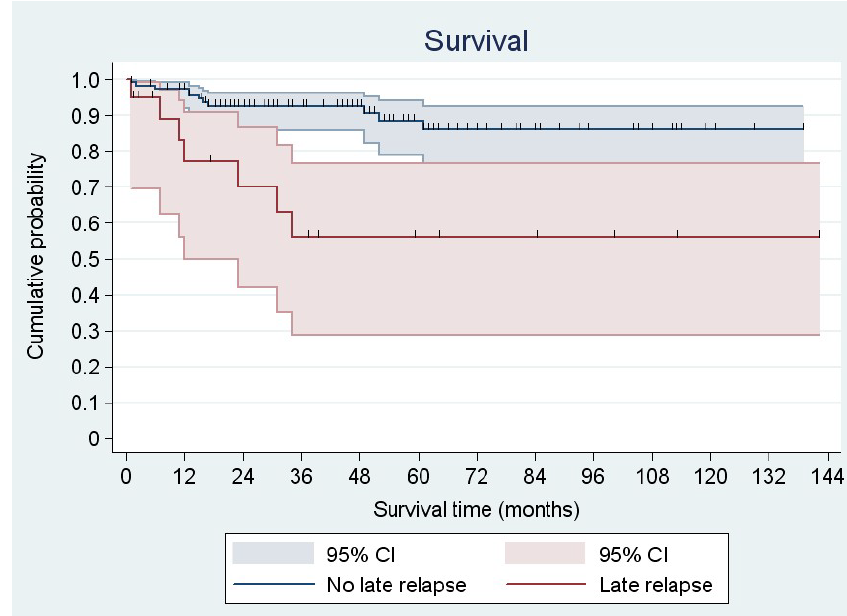
Kaplan-Meier analysis of overall survival after stratification for late relapse.